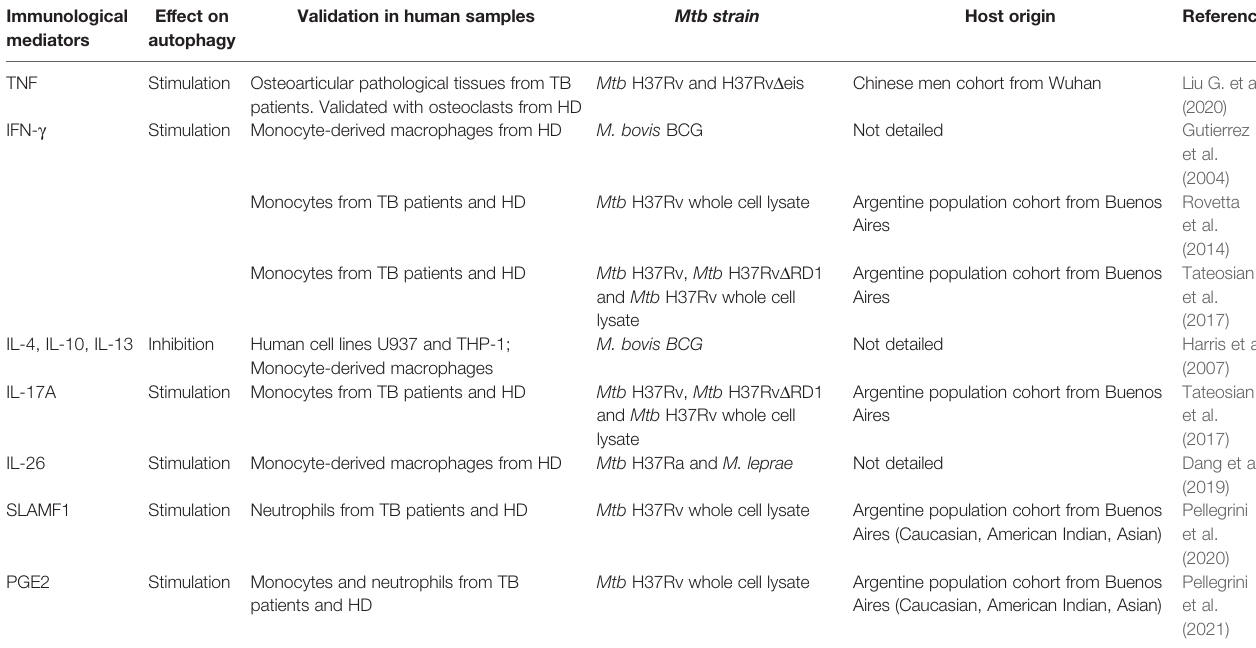
TABLE 1 | Immunological mediators modulate the autophagy process during active